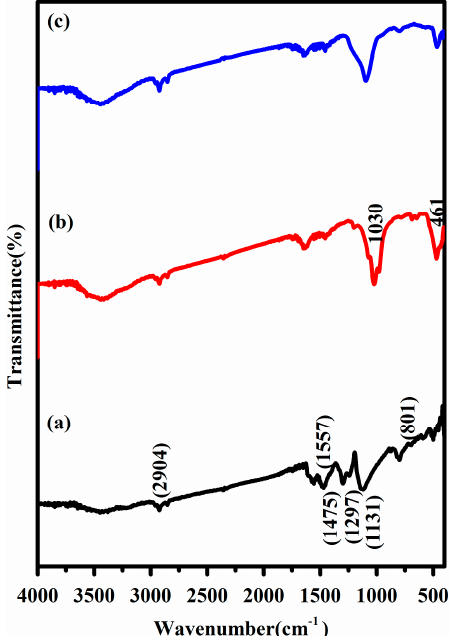
Figure 2. Spectrum of ( a ) PAni ( b ) sulfur / sieved sepiolite / PAni (S / SvSp / PAni) and ( c ) sulfur / post-treated sepiolite / PAni (S / PTSp / PAni).